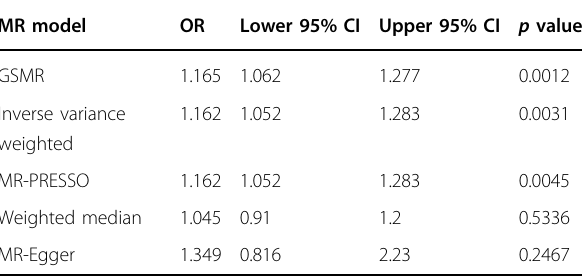
Table 3 Forward MR results of BIP-SCZ as a risk factor for self-reported COVID-19 (D1), using 96 instrument